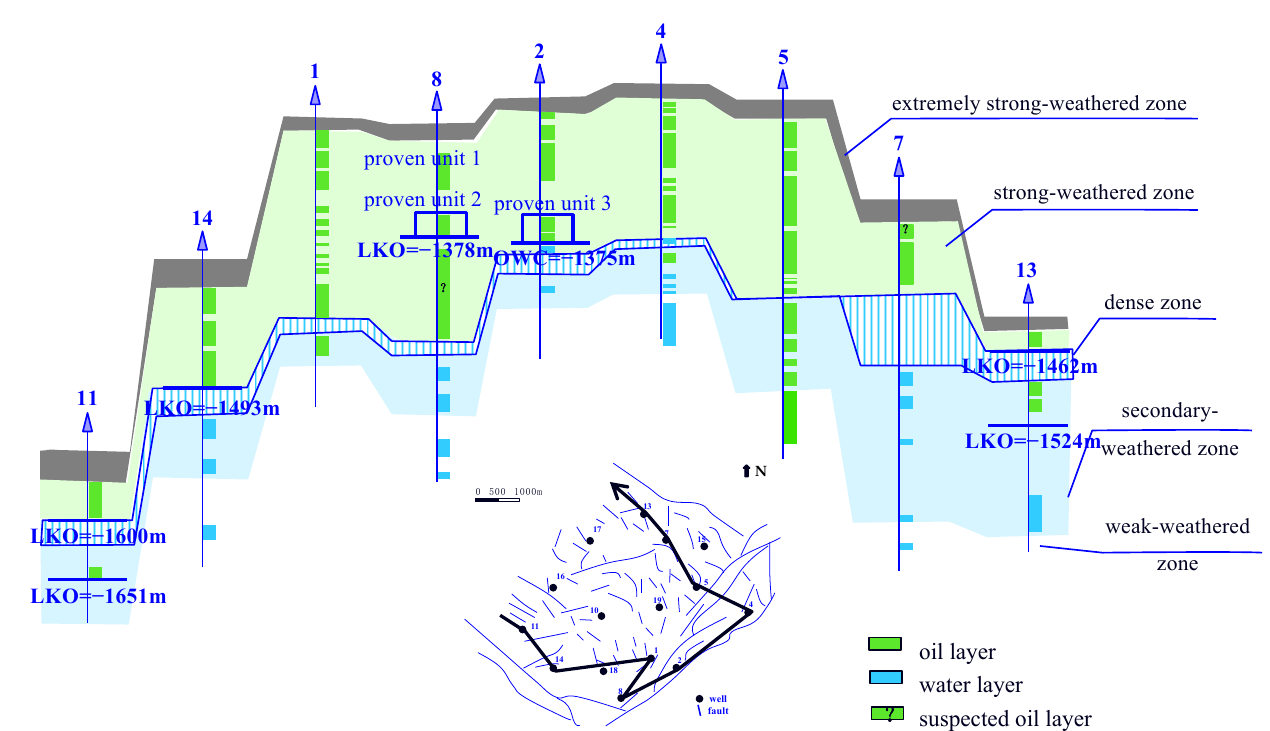
Figure 1. Vertical zoning characteristics of PL oilfield reserves during the oil-in-place assessment stage. LKO refers to the bottom boundary of the oil layer and OWC refers to the oil–water interface.